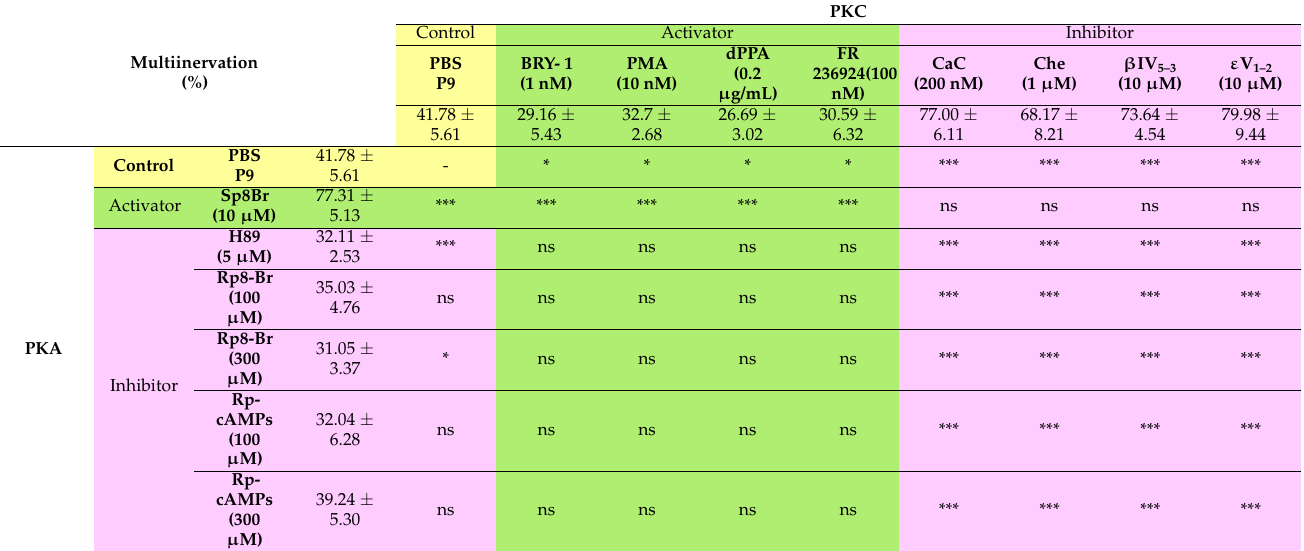
Table 2. Percentage of multiinervation in P9 NMJs.